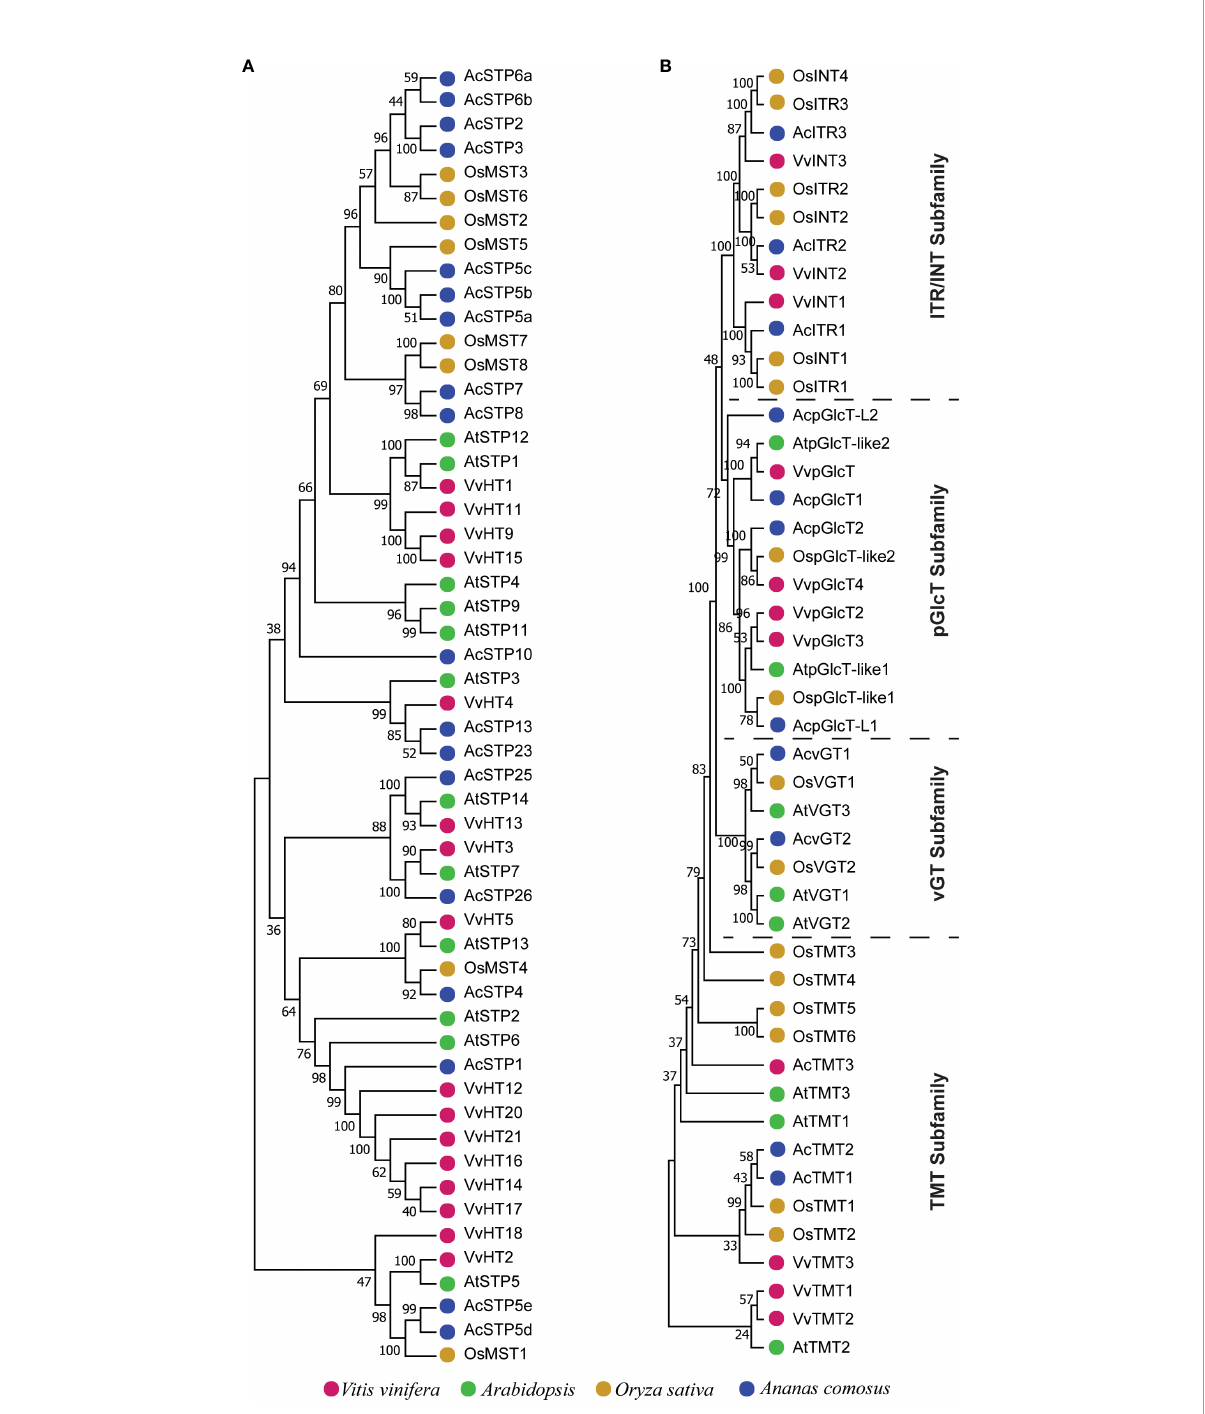
FIGURE 6 Phylogenetic tree of sugar transporters subfamilies. The trees were built with the neighbor-joining algorithm using protein sequences. (A) The phylogenetic tree of the STP subfamily. (B) The phylogenetic tree of the TMT, vGT, pGlcT and ITR/INT subfamilies. Sugar transporters genes of pineapple in the phylogenetic trees are marked with blue, and the sugar transporters genes other species are marked with different colors as labeled at the